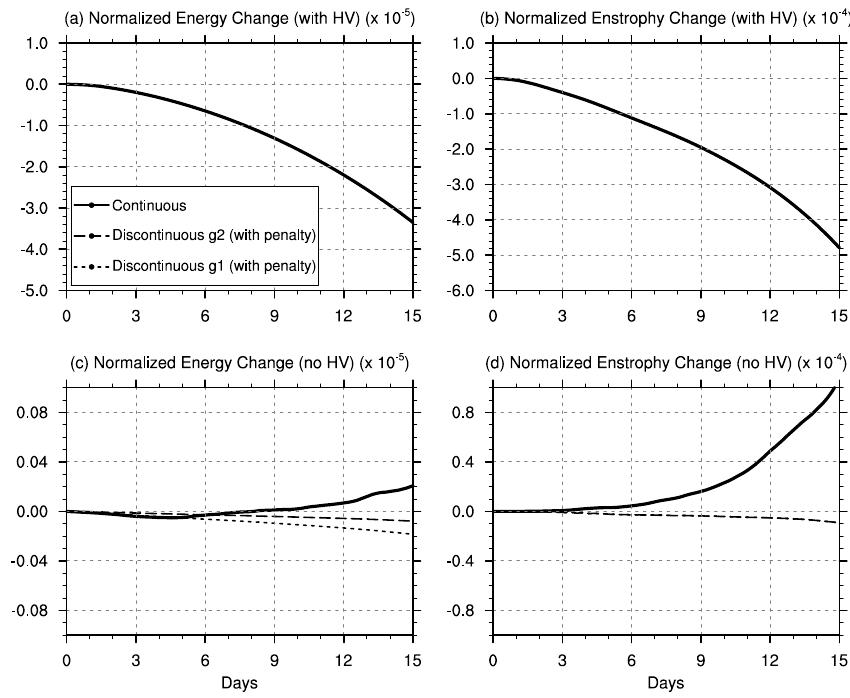
Figure 7. Normalized total energy and potential enstrophy change for the zonal flow over an isolated mountain test with n e = 16 and n p = 4 over a 15-day simulation. In (a) all simulations show roughly equivalent energy and enstrophy loss and so all lines are coincident. In (c) and (d) the simulation with continuous elements is beginning to experience instability, leading to total energy and enstrophy growth after approximately 6 days of simulation time.